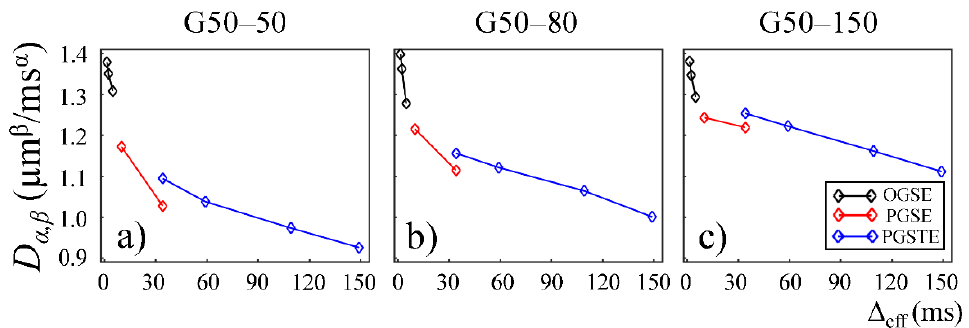
Figure 6. Plot of D α,β versus effective diffusion time, Δ eff , for gels G50 – 50 ( a ), G50 – 80 ( b ), and G50 – 150 ( c ). The data acquired by using the OGSE, PGSE, and PGSTE pulse sequences are marked in black, red, and blue, respectively.